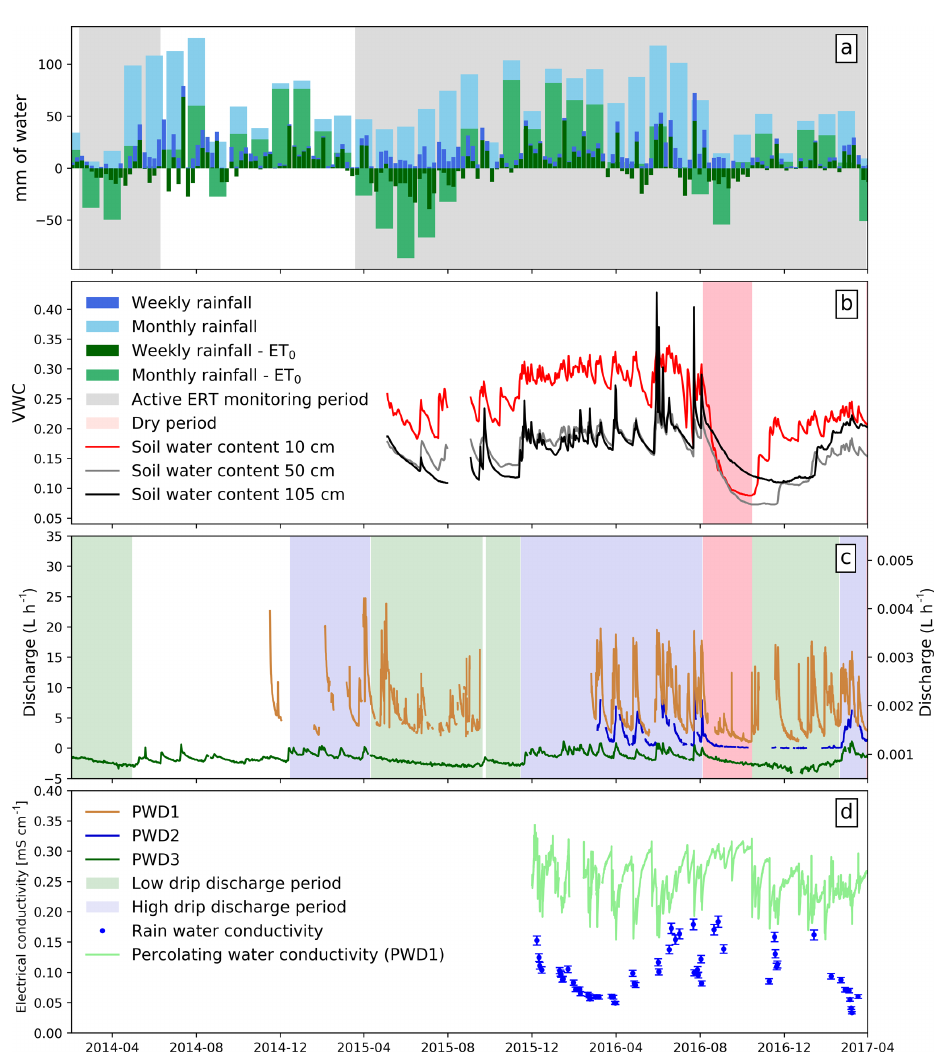
Figure 2. (a) Weekly and monthly rainfall as well as effective rainfall (estimated as rainfall – ET 0 ). Shaded areas represent the periods with active ERT monitoring. (b) Three of the five WCR probe data sets for the 10, 50 and 105cm depths. The long drought of August and September 2016 is highlighted in pale red. (c) Data set for the three percolation water discharge (PWD) stations. Periods of low discharge and high discharge are highlighted based on values from the PWD3 and PWD2 when available. (d) Electrical conductivity of rain water (for rainfall event > 5mm) and percolation water measured at the PWD1 station. Error bars stand for the instrumental error announced by the manufacturer ( ±